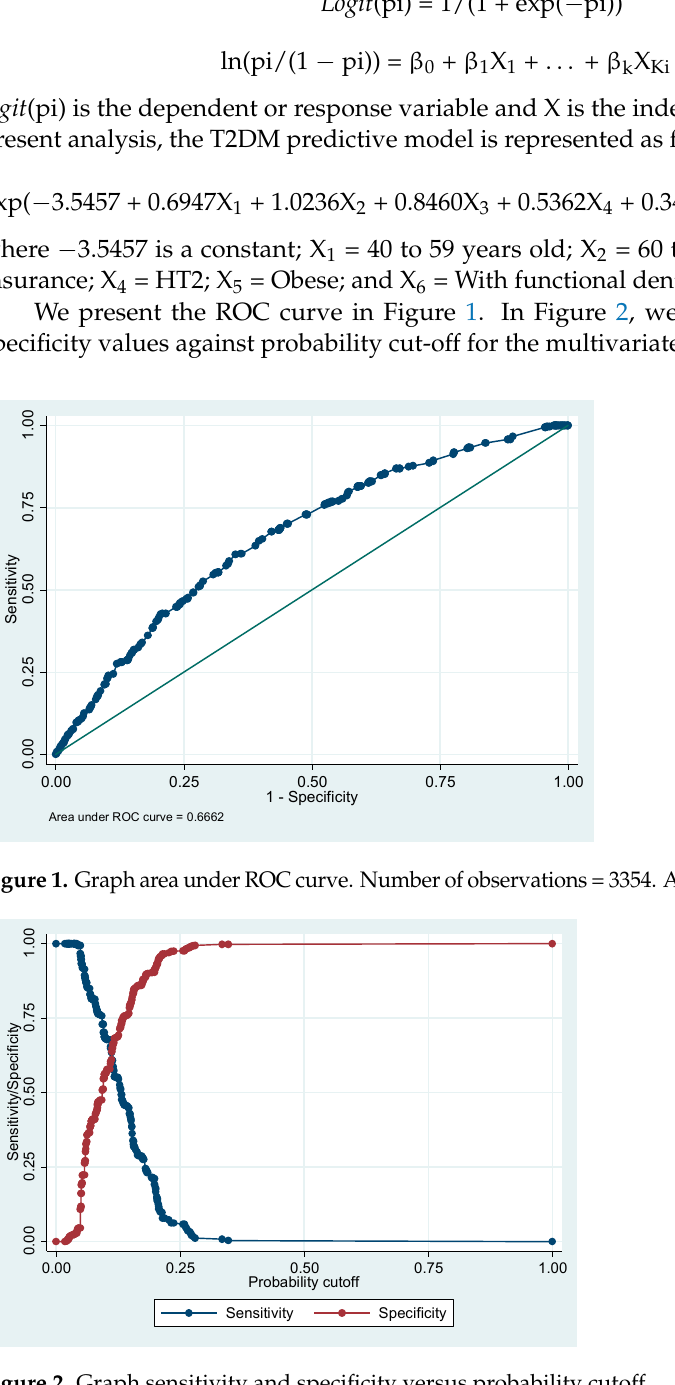
Figure 2. Graph sensitivity and specificity versus probability cutoff.